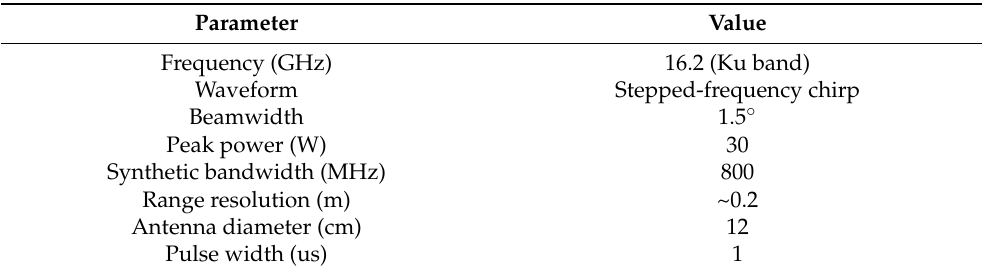
Table 1. Main entomological radar